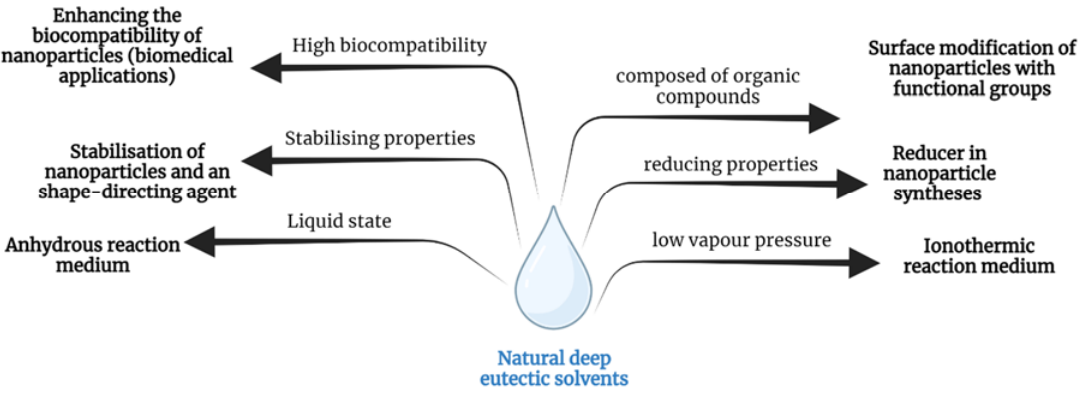
Figure 6. Properties and applications of natural deep eutectic solvents in nanotechnology (created with BioRender.com).